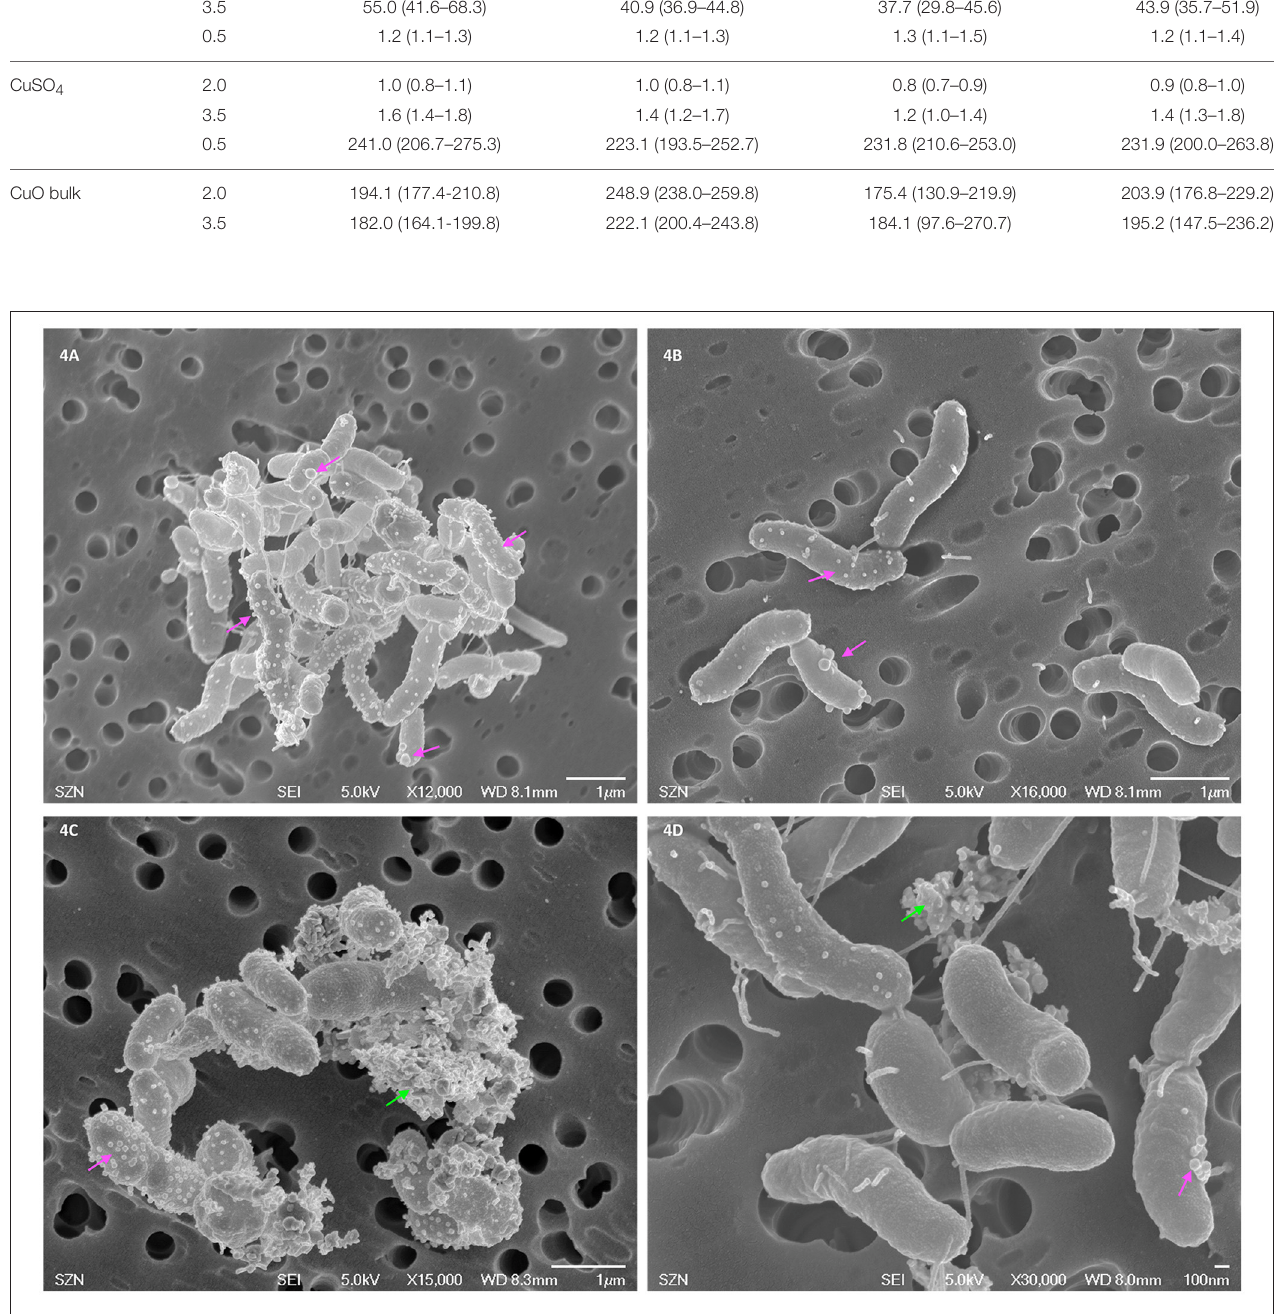
Frontiers in Microbiology |